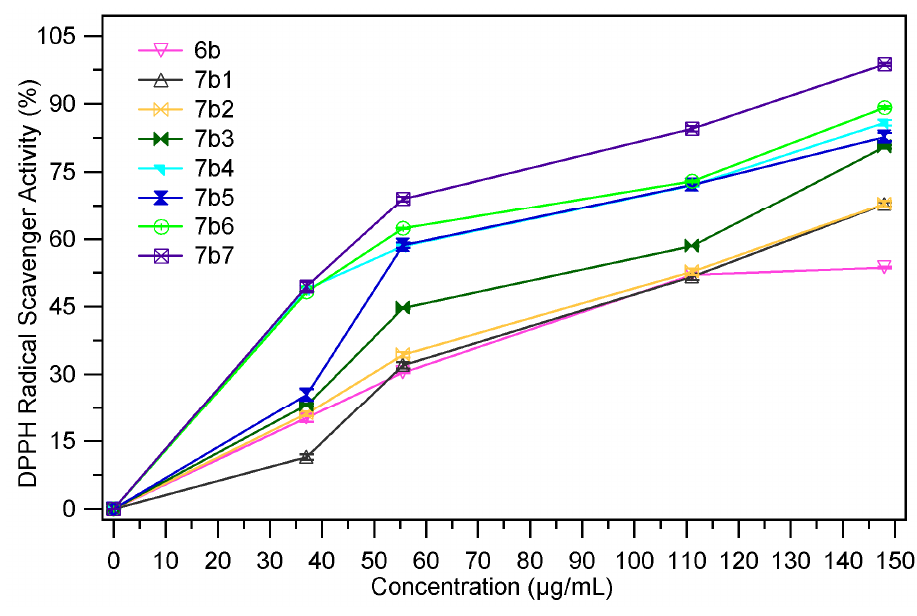
mg/mL) of the derivatives 6a , 6b , 7a 50